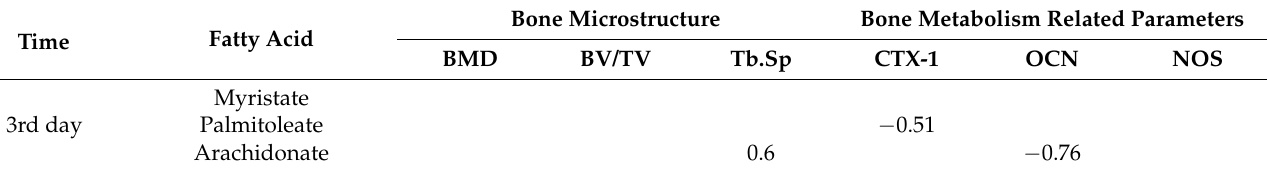
Table 2. Correlation coefficients of significant differential fatty acids with bone microstructure and bone metabolism related